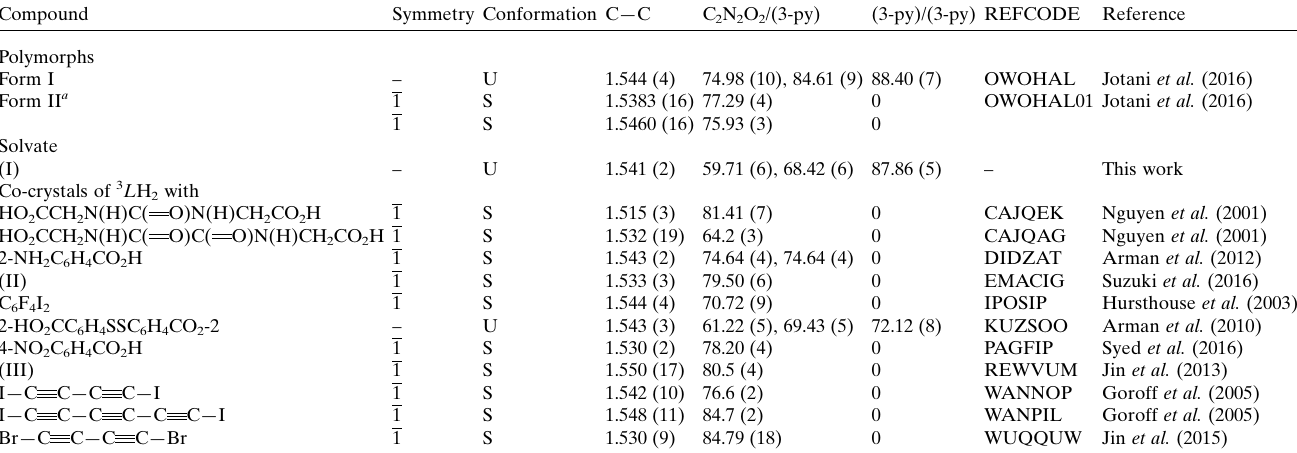
Table 5 Geometric data, i.e. central C—C bond lengths (A˚ ) and dihedral angles ( (cid:3) ), for 3 L H 2 in its polymorphs, solvates and (neutral) co-crystals; see Scheme 2 for the chemical diagrams of (II) and